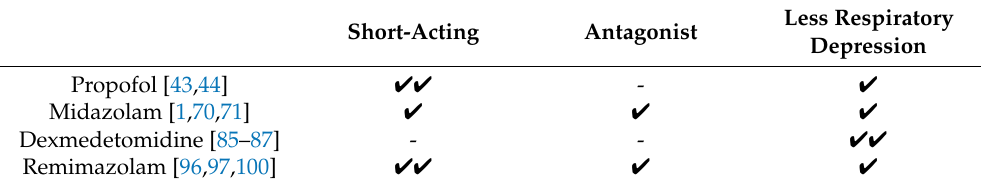
Table 2. Advantages of each